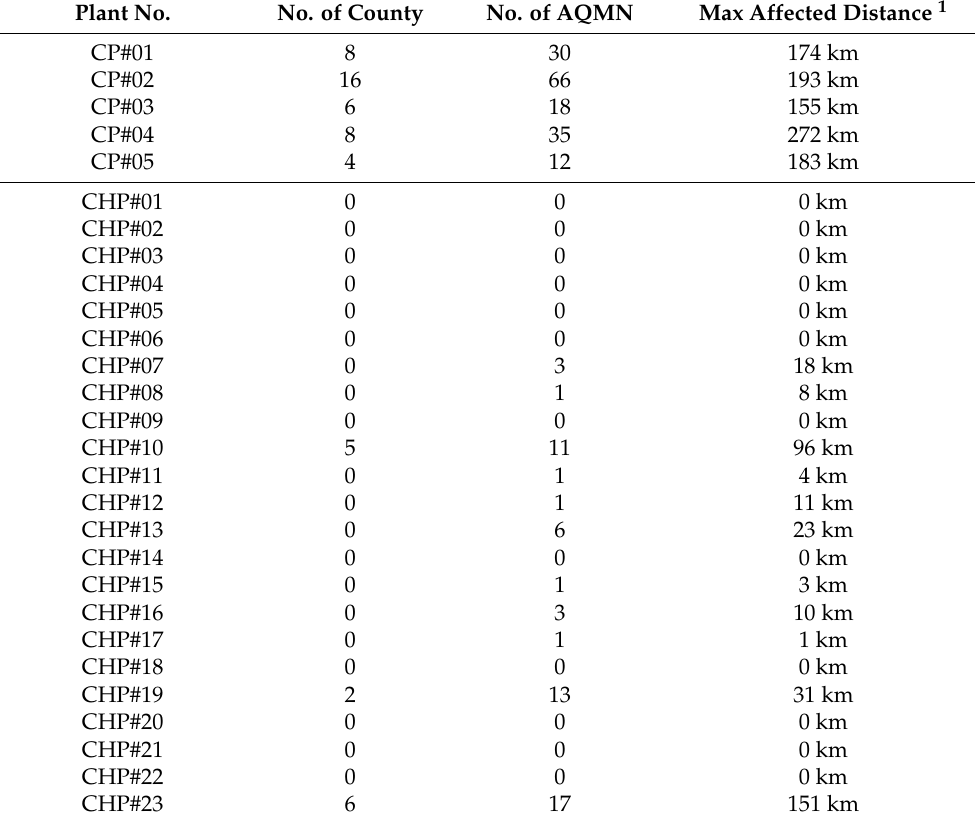
Table 4. Statistics of numbers of county, AQMN, and maximum affected distance from each coal-fired plant (CP and CHP) with greater than 0.1 µ g/m 3 PM 2.5 increment. Plant